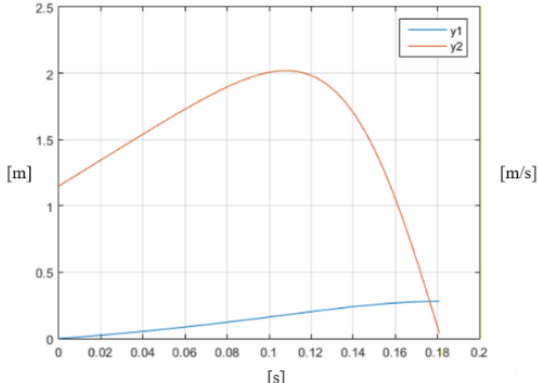
Figure 9. Change of dynamic force 𝐹(𝑥,𝑥̇) at an operating temperature of +15 °C and 𝜂 𝐶𝑇 = 0.4 .